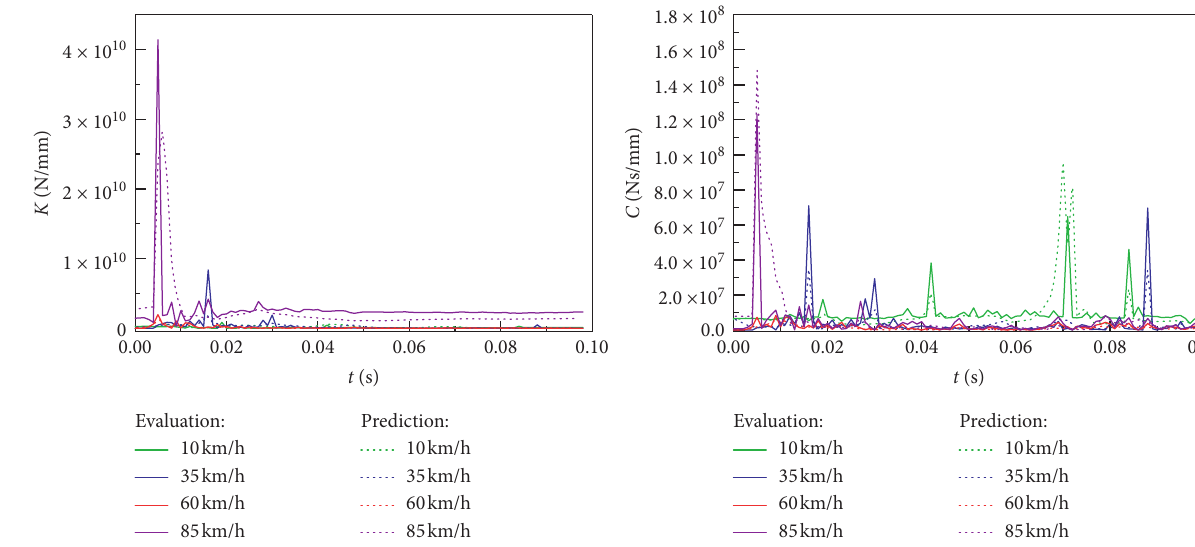
Figure 7: Head car comparisons of estimation and prediction.